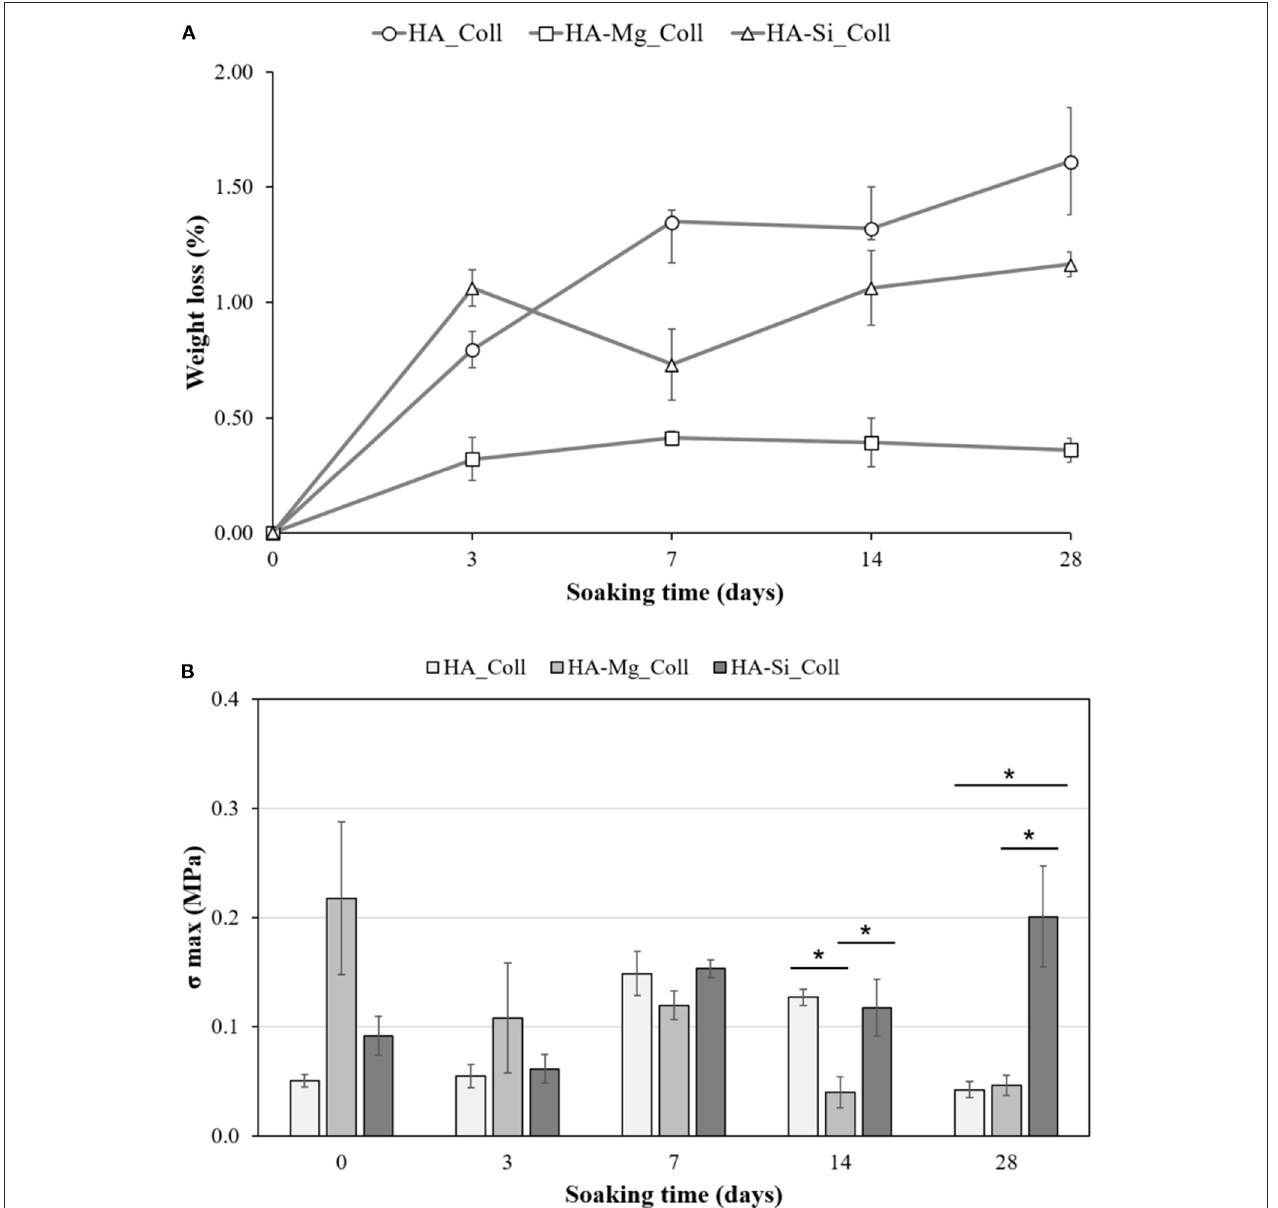
FIGURE 5 | Stability test on HA_Coll, HA-Mg_Coll, and HA-Si_Coll scaffolds. Plot of weight loss % (A) and stress at failure ( σ max ) (B) after 0, 3, 7, 14, and 28 days of aging in TRIS-HCl pH 7.4 at 37 ◦ C (average values ± SEM, n = 6, * P <